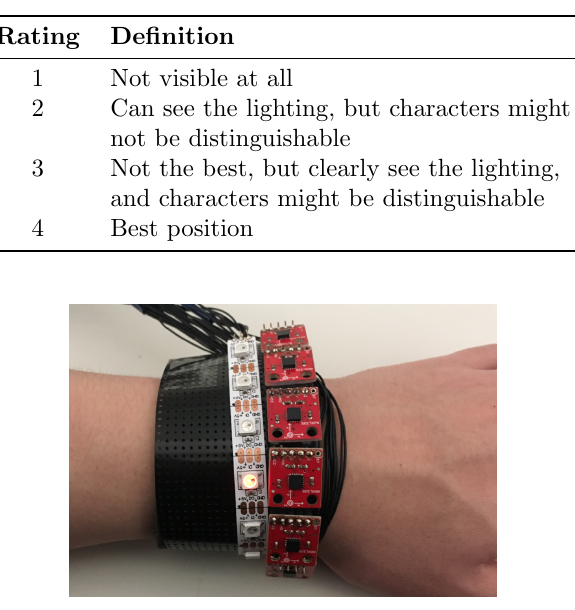
Figure 4. The most visible LED selected by the